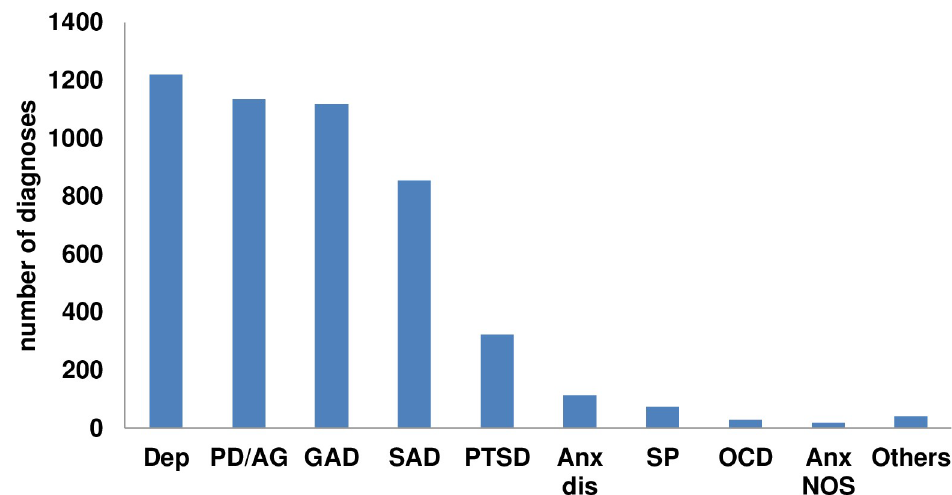
Fig 5. Total number of diagnoses of each type in subsample 2. Note . Dep: Depression; PD/AG: Panic disorder and/ or agoraphobia; GAD: Generalized anxiety disorder; SAD: Social anxiety disorder; PTSD: Posttraumatic stress disorder; Anx dis: Anxiety disorders; SP: Specific phobia; OCD: Obsessive-compulsive disorder; Anx NOS: Anxiety not otherwise specified. “Others” included somatoform disorder (n = 10), adjustment disorder (n = 10), eating disorders (n = 9), alcohol use disorder (n = 4), substance use disorder (n = 4), and anxiety/depression NOS (n = 4).